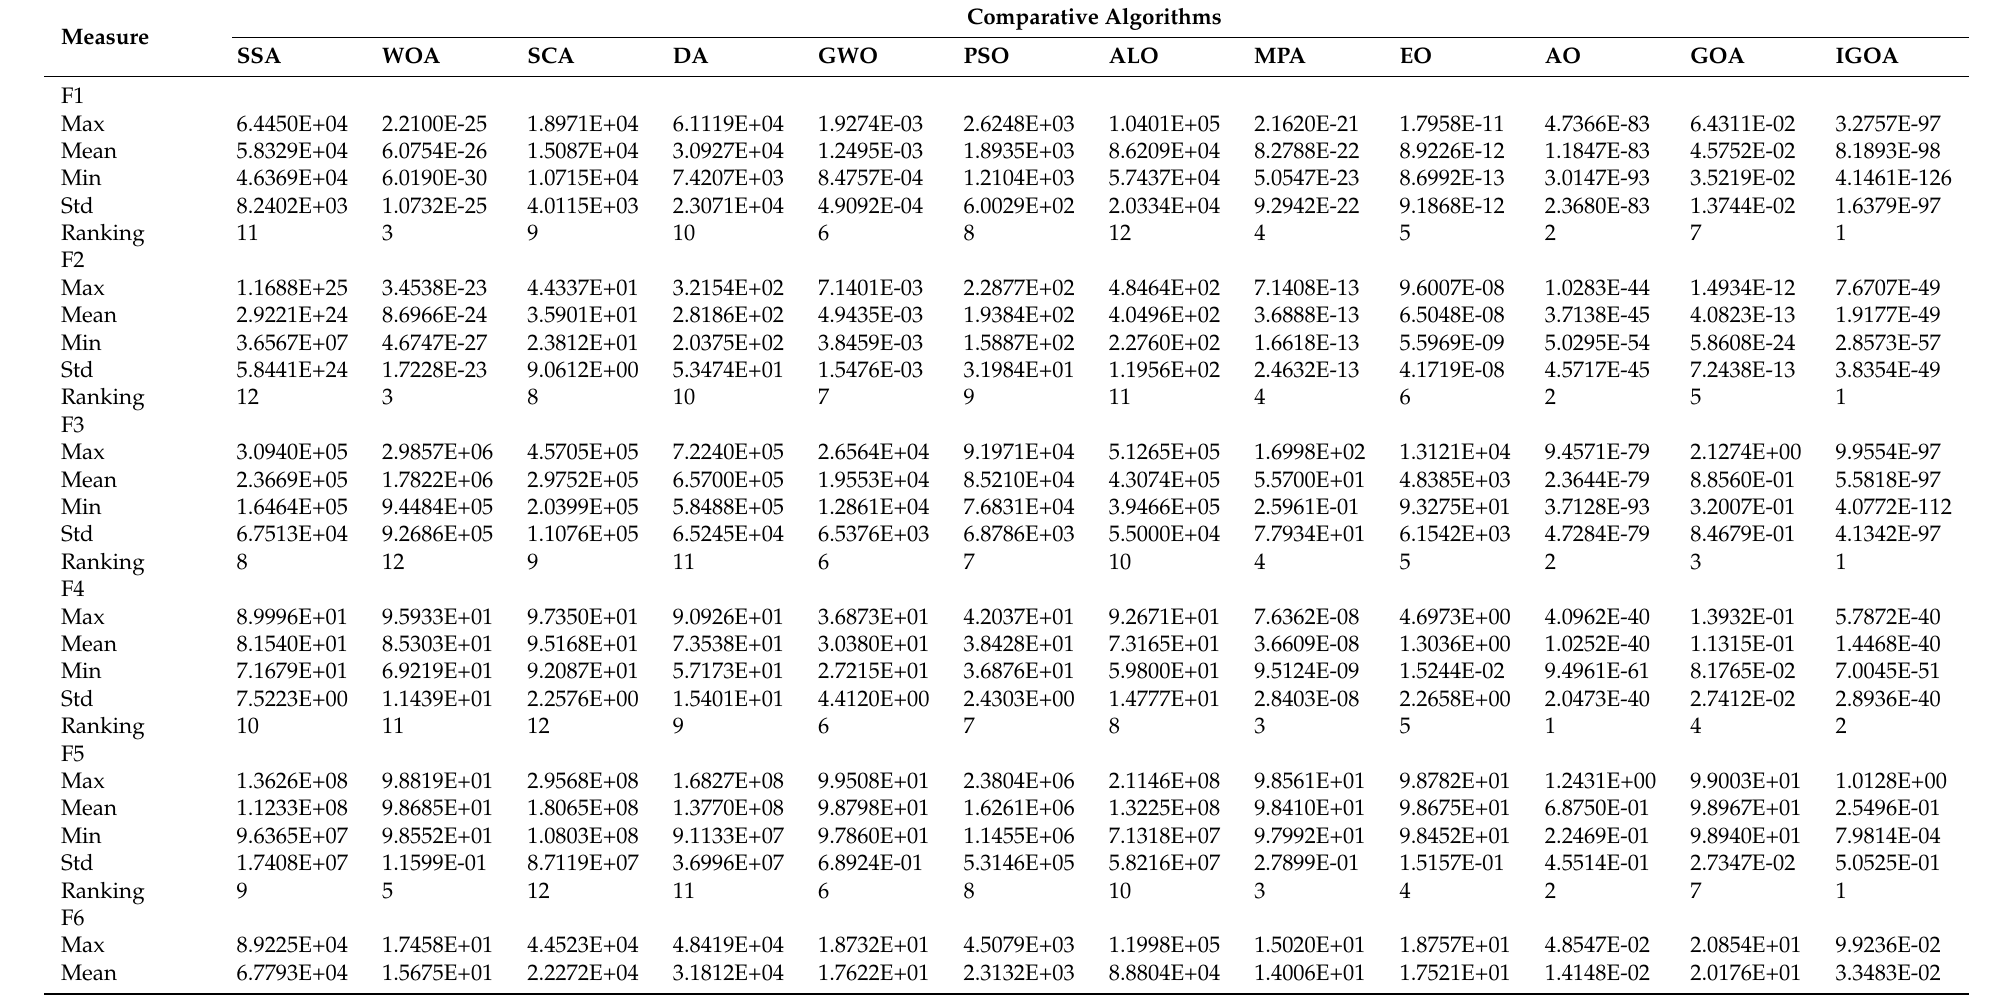
Table 8. The results of the proposed IGOA and other comparative methods using classical benchmark functions (F1–F13), where the dimension size is